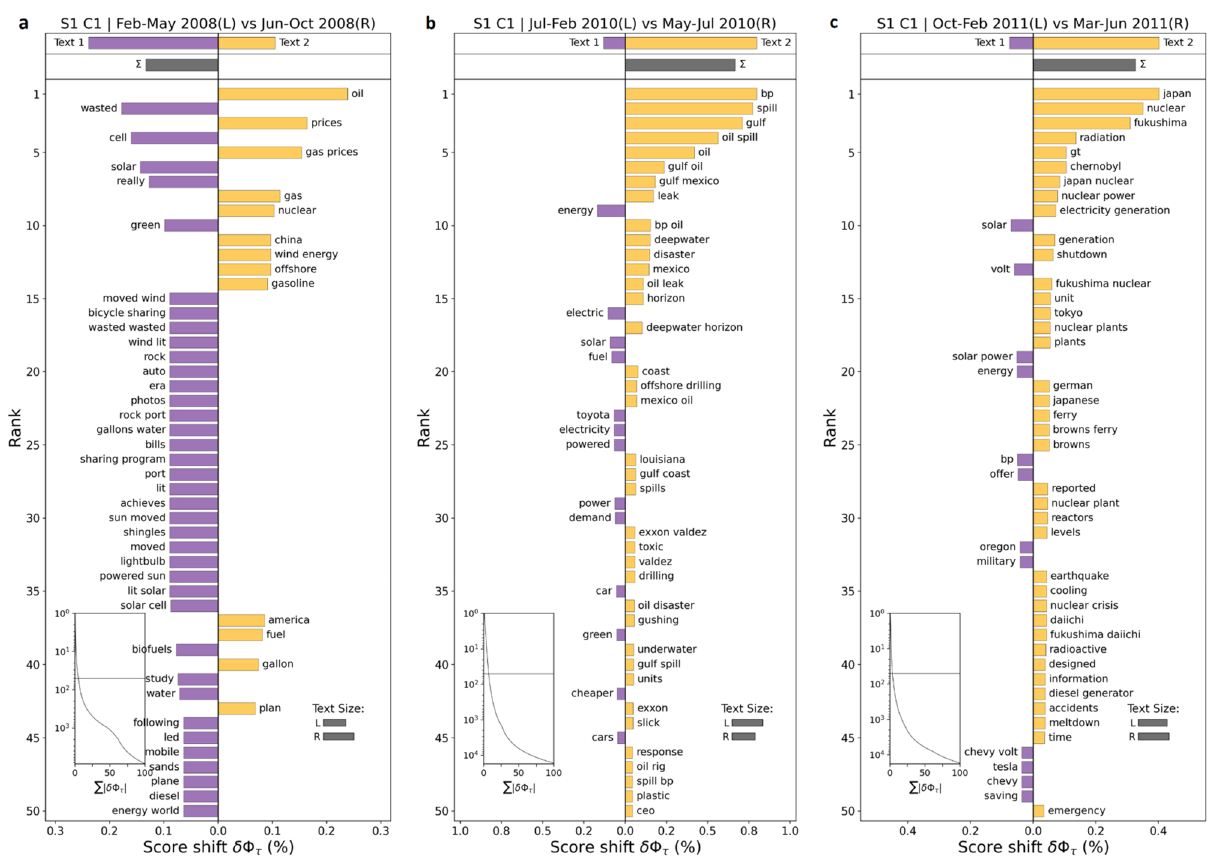
Figure 10. Word shift graphs for Energy cluster in Sample 1 showing the texts from the time periods with unusually high vs. low user activity. A deeper look at the underlying keywords from the respective time periods of unusually high activity reveals that the discussions within the Energy cluster spiked in 2008 due to oil price shock ( a ), in 2010 due to the Deepwater Horizon oil spill ( b ), and in 2011 due to the Fukushima nuclear disaster ( c